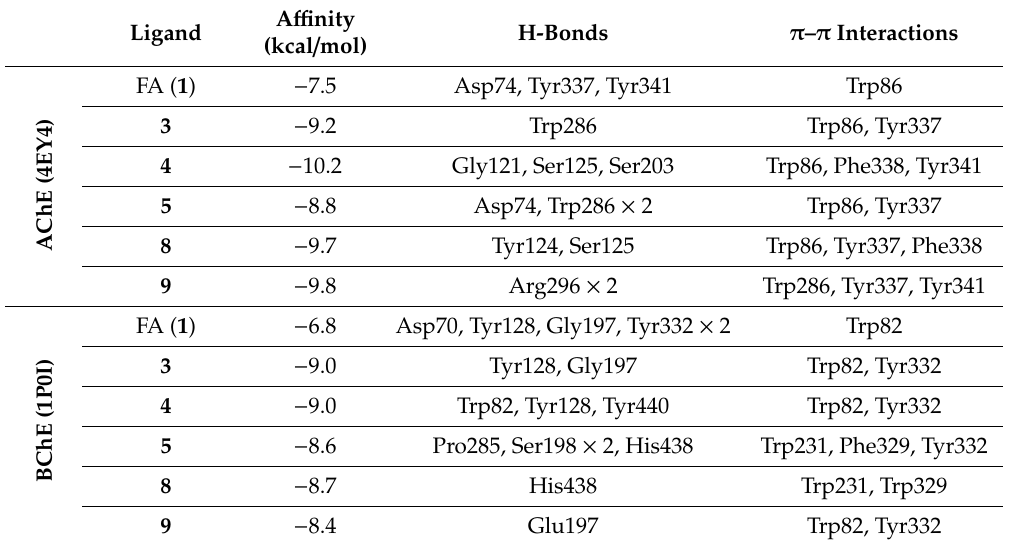
Table 3. Acetylcholinesterase (AChE) and butyrylcholinesterase (BChE) docking a ffi nity and interactions a